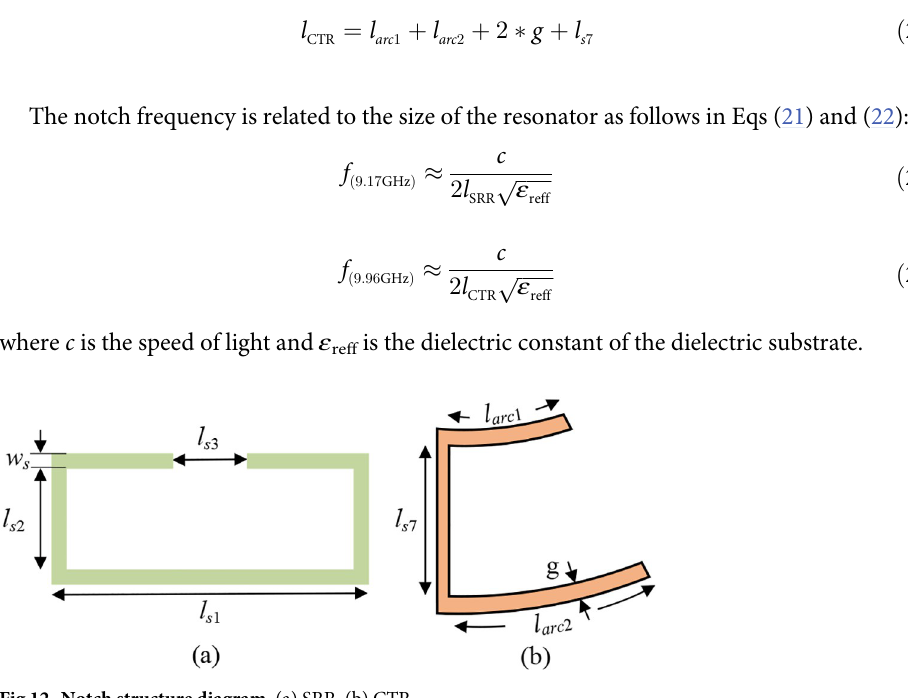
waveguide technology can make full use of the space of the top and bottom layers of the circuit board, which is conducive to the miniaturization of the circuit structure.